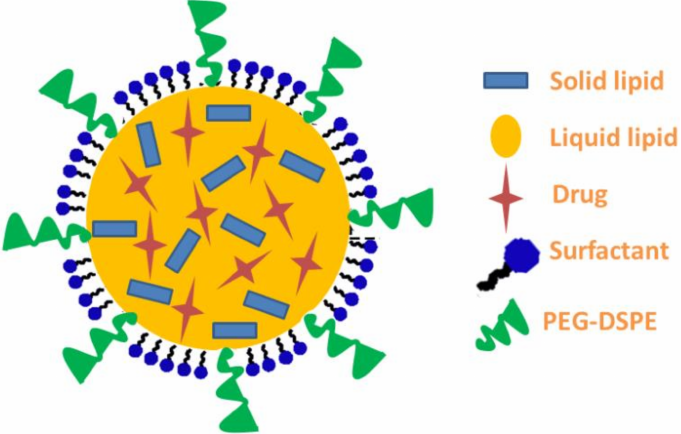
Figure 1. Representing the structure of the prepared ATO-NLC shielded with